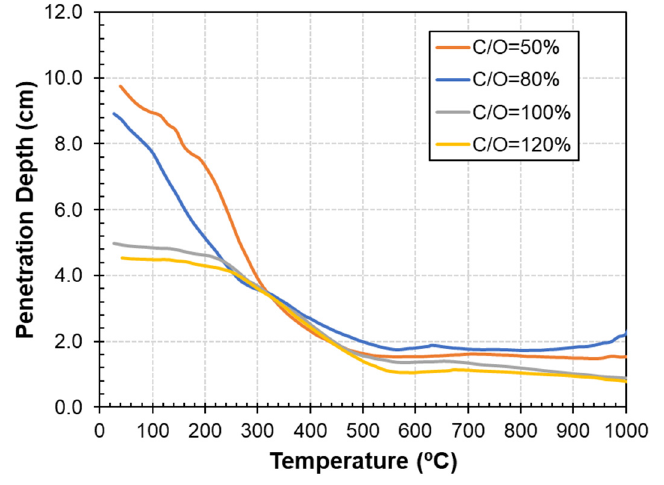
Figure 5. Penetration depth of samples with different carbon content as a function of temperature.